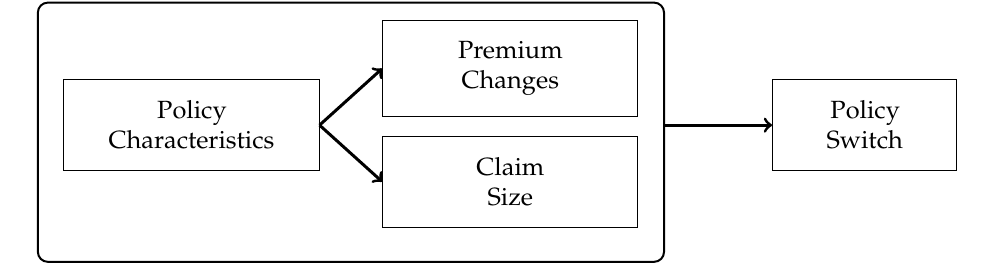
Figure 4. Illustration of decision making flows for each policyholder.